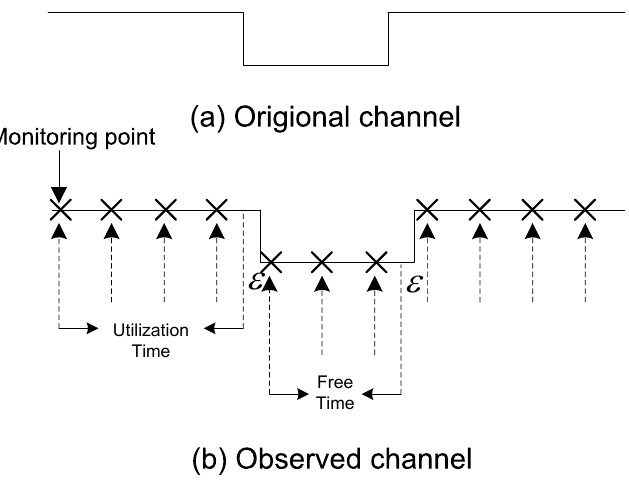
Figure 4. Observing free and utilization times through PU activity